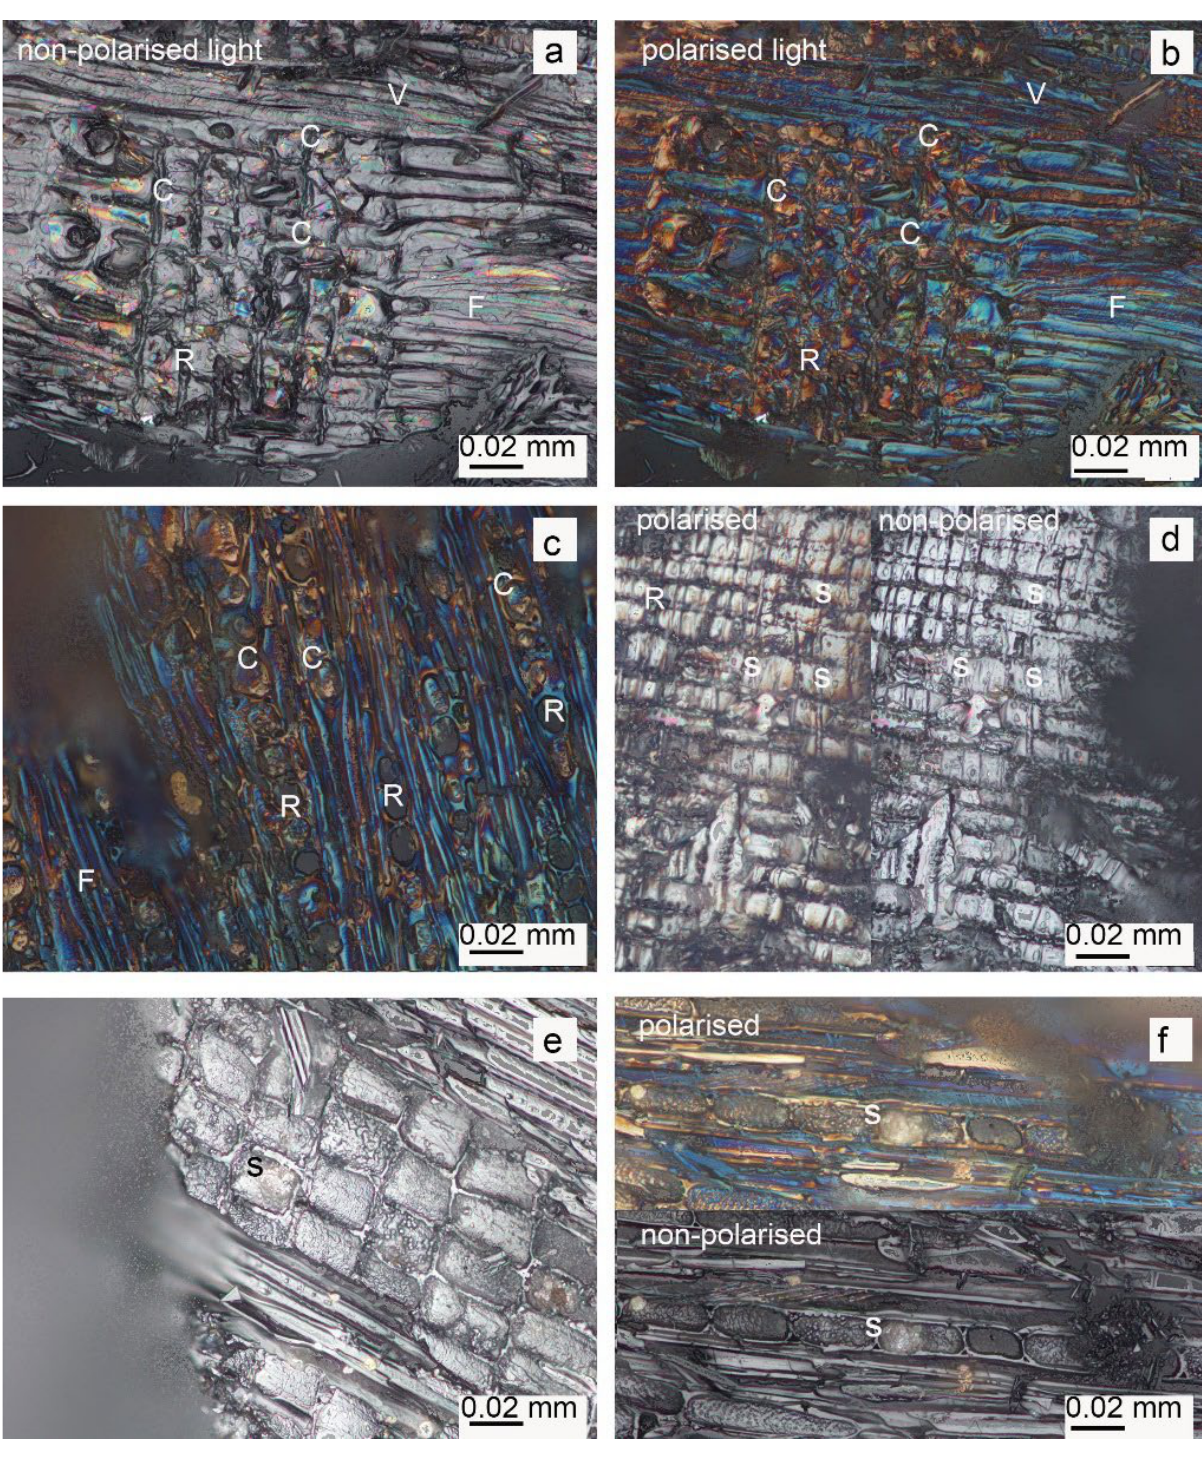
Figure 2: Diagnostic characteristics of archaeological charcoal: (a–c) Spirostachys africana, (d) Shirakiopsis elliptica and (e,f) Sclerocroton integerrimus. (a) In Spirostachys africana , SPCA B4b 62, there are prismatic crystals (C) in the procumbent ray cells (R), under non-polarised light. (b) These appear shiny under polarised light in radial longitudinal section, matching those of the Spirostachys africana SJL 103 reference material. The vessel (V), fibre (F) and ray cell (R) walls are also birefringent under polarised light. (c) In Spirostachys africana, SPCA D5c 51, tangential longitudinal section, the ray cell walls are cut away and the crystals underneath are present and shiny, matching those of the Spirostachys africana SJL 103 reference material when magnified 500x. (d) In Shirakiopsis elliptica archaeological material, MOD C6a 46, silica bodies (S) are present as grains and dots in ray cells and appear opaque under both polarised and non-polarised light. Rays are heterocellular, with mixed upright, square and procumbent cells, in radial longitudinal section. (e) In Sclerocroton integerrimus archaeological charcoal, SPCA B4b 66, the silica bodies in the ray cells are spheroidal or irregularly shaped and opaque in non-polarised light in radial longitudinal section and in both polarised (f) and non- polarised light in tangential longitudinal